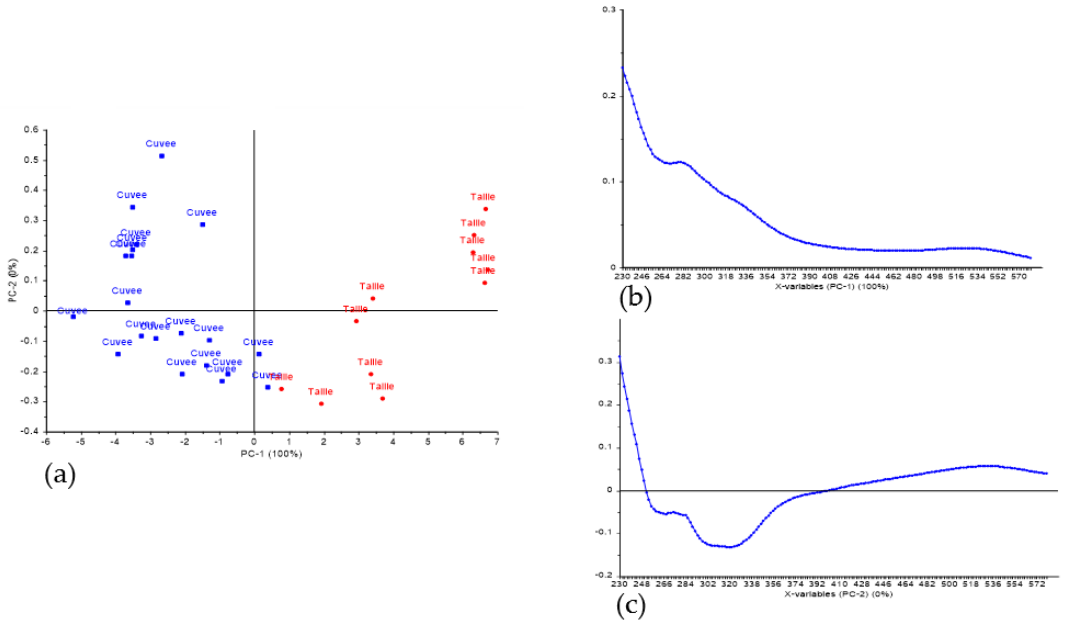
Figure 5. PCA scores and loadings plots of 2012 Pinot noir juice samples from the commercial scale trial discriminating cuvée from taille . Scores plots ( a ); PC 1 ( b ) and PC 2 ( c ) loadings.